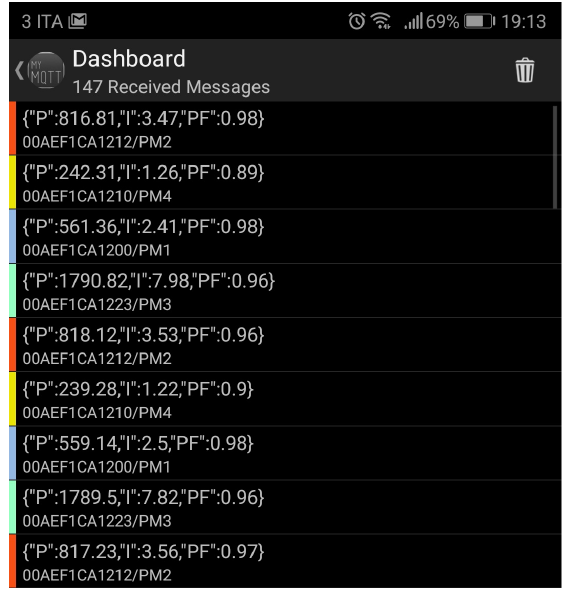
Figure 12. Screenshot of received MQTT